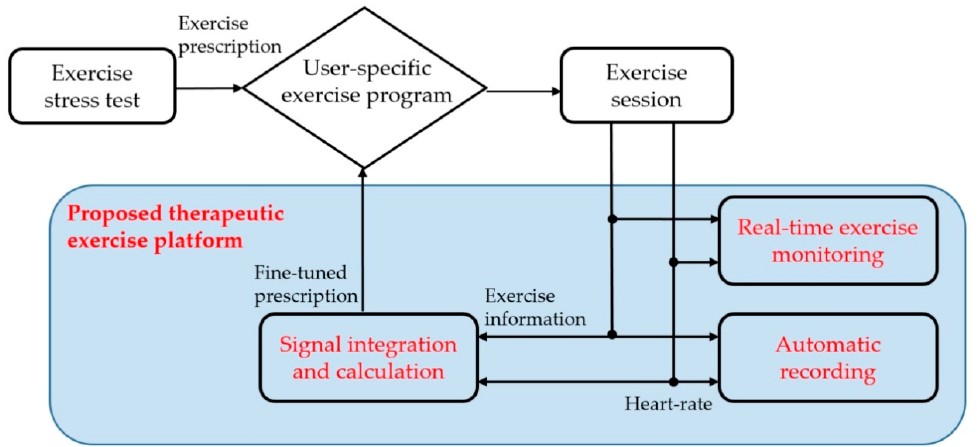
Figure 1. The proposed scheme of the proposed therapeutic exercise